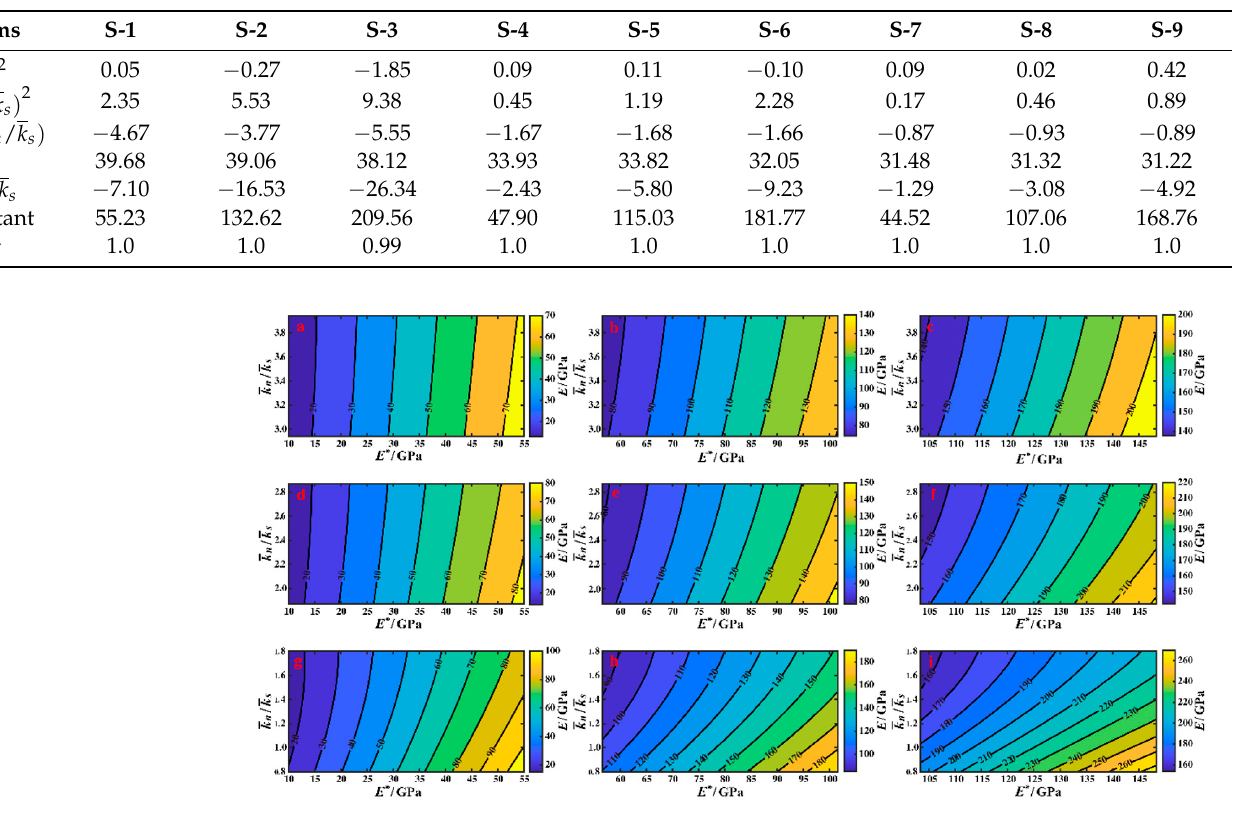
Figure 15. Response surface of elastic Figure 15